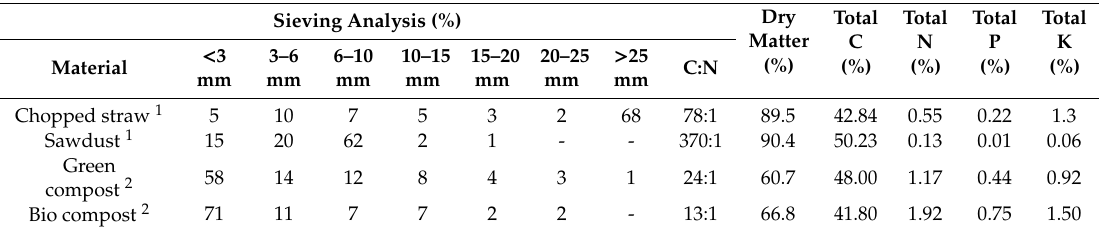
Table 3. Sieving analysis and dry matter content, C %, N%, P%, K% and C:N of incorporation